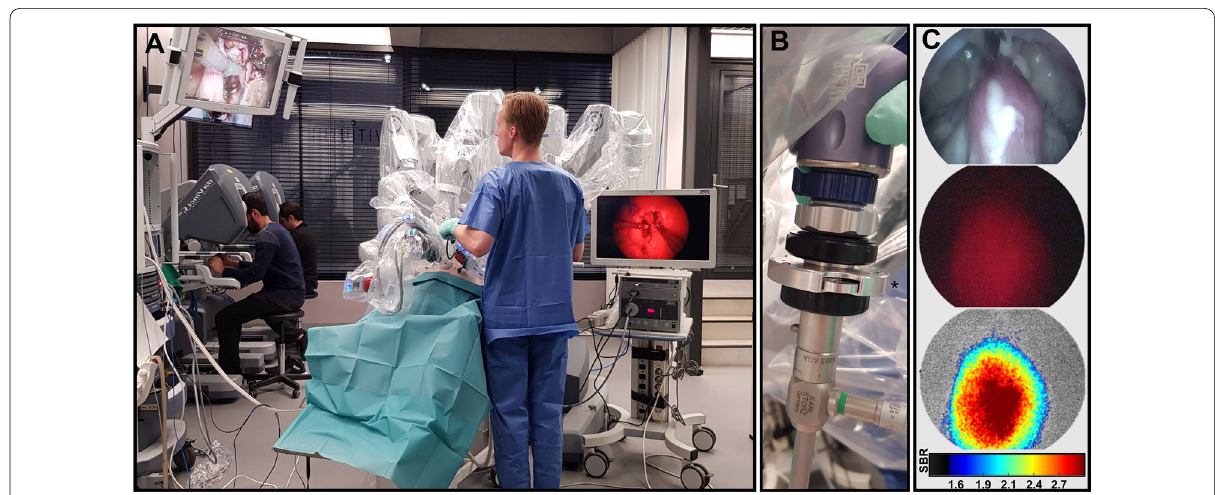
Fig. 2 In vivo imaging of basal PSMA levels in the porcine prostate using clinical imaging equipment. A Imaging setup showing the operating surgeons (on the left) handing the Da Vinci surgical robot (center) and the Cy5-dedicated laparoscopic imaging setup from KARL STORZ (on the right; [26, 27]). B ) In-house developed click-on multispectral filter wheel (*) enabling switching between white light imaging and Cy5 imaging. C In vivo visualization of the prostate using white light imaging (top), receptor-mediated PSMA imaging (basal expression) after intravenous administration of EuK ‐ (SO 3 )Cy5 ‐ mas 3 (center; red on black) and real-time color coding of the fluorescence signal and corresponding signal-to-background ratio (SBR) in the prostate using in-house developed software [26,